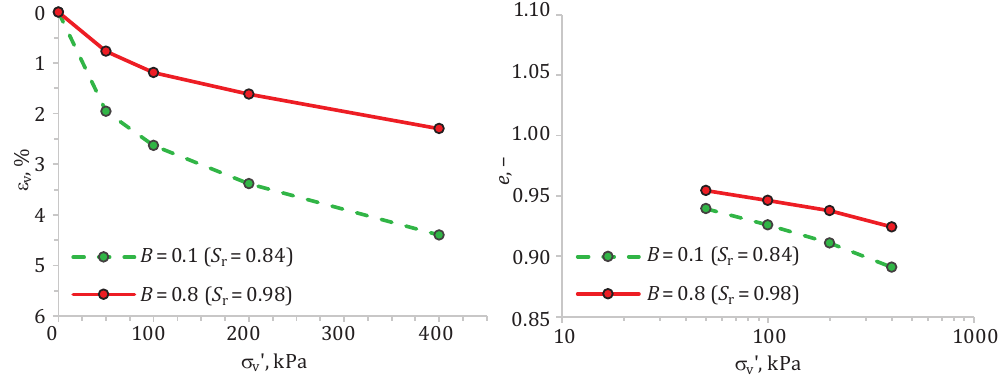
Figure 7. Vertical compression ε v versus pressure σ v ’, and void ratio e versus log pressure σ v ’ plots of saturated and non-saturated fly ash with 15% of bentonite